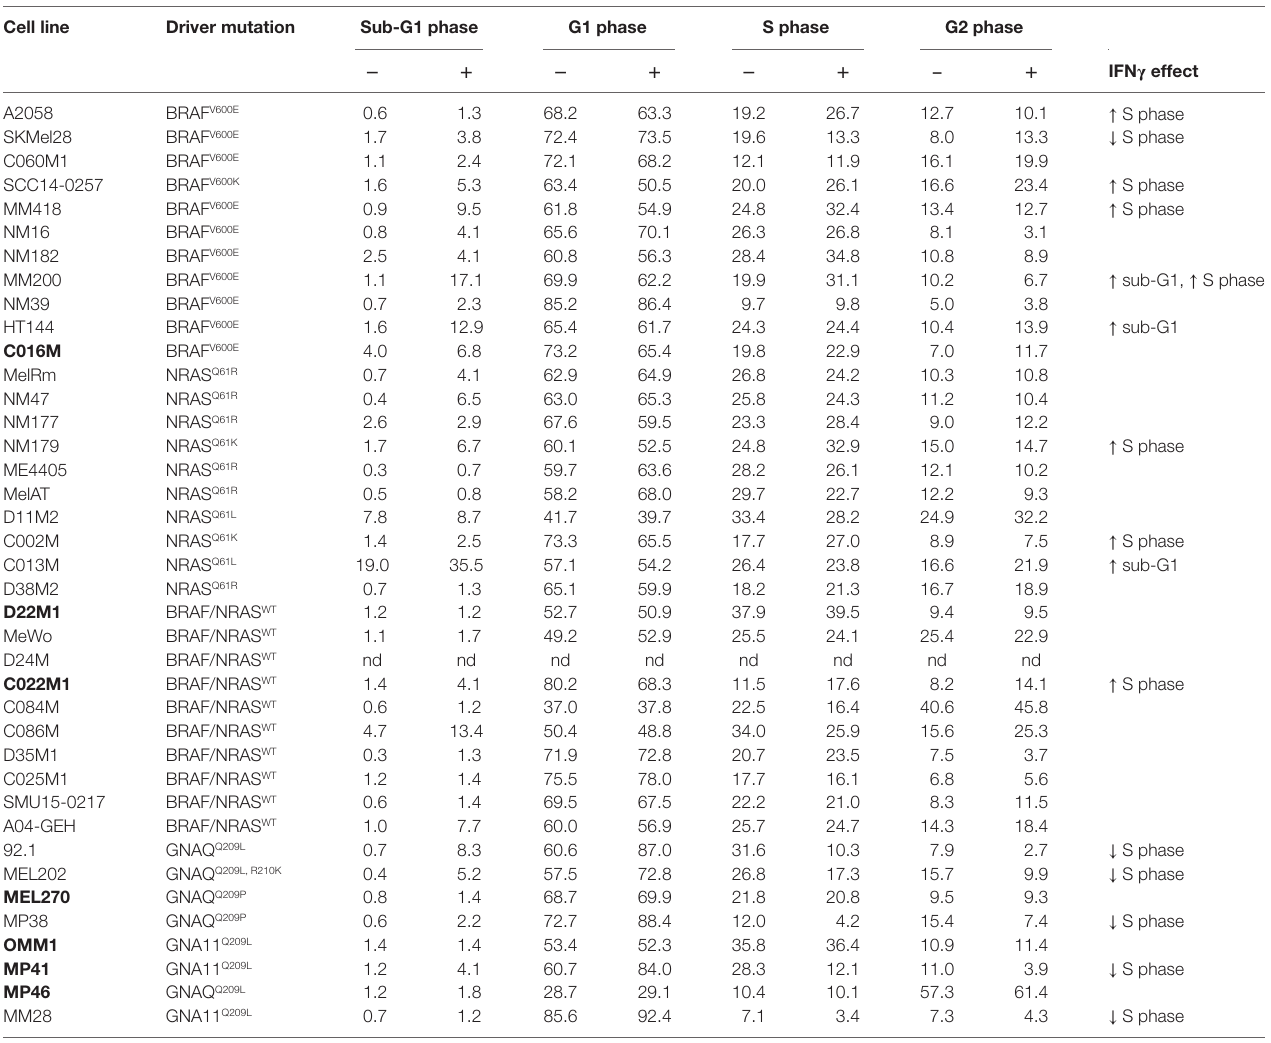
TaBle 2 | IFN γ -mediated cell cycle effects in melanoma cells. cell